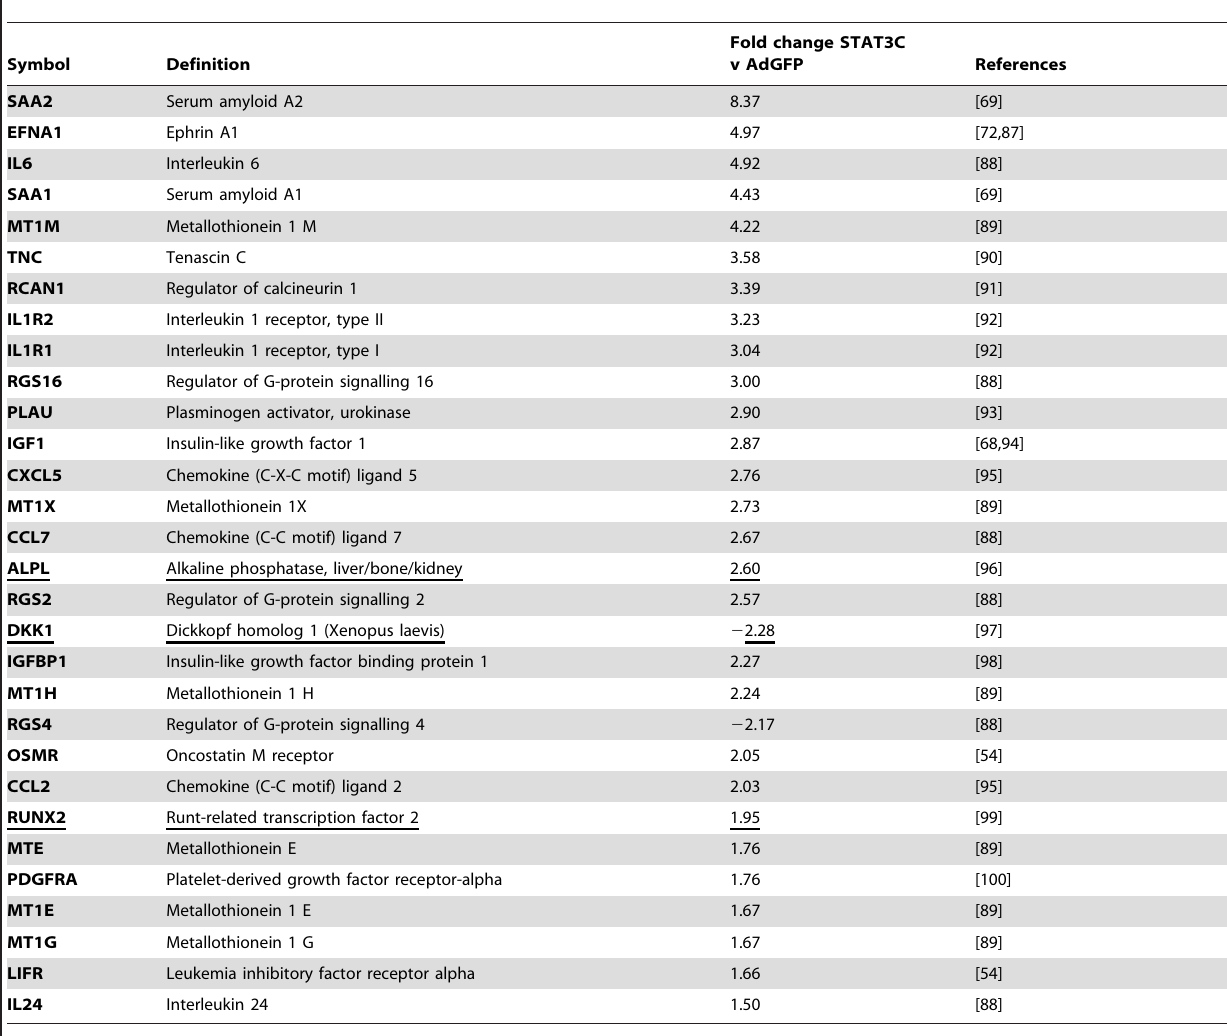
Table 4. Selected genes associated with OB differentiation and/or